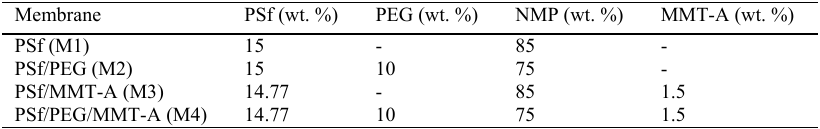
Table1. Casting solution composition of various neat and adsorptive membranes